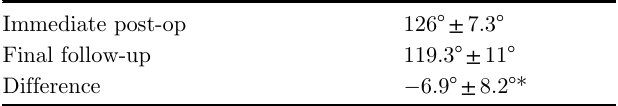
Table 1. Patient characteristics. Table 2. Neck-shaft angle.